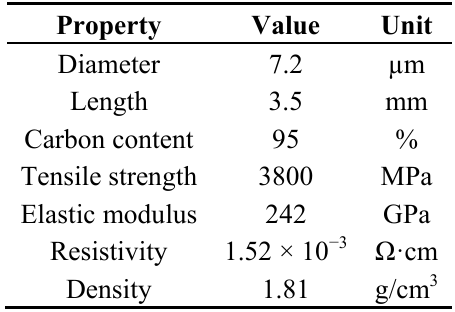
Table 1. Carbon fiber PANEX 35